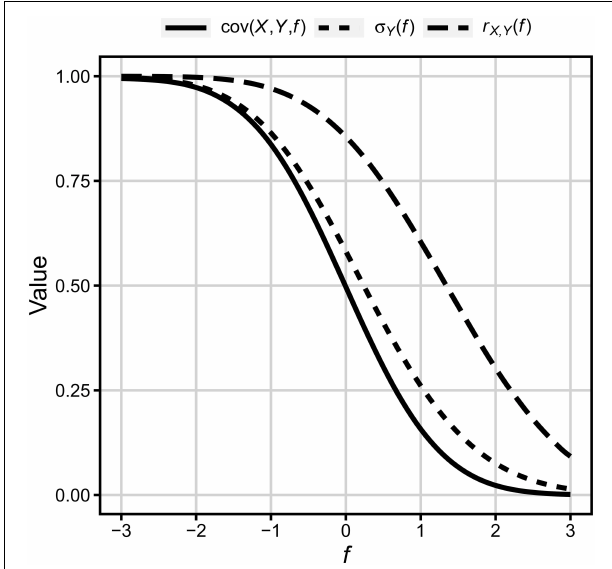
FIGURE 3 | Covariance, standard deviation, and correlation as functions of floor (in units of standard deviation of X , 0 = ¯ x ). See description in text.